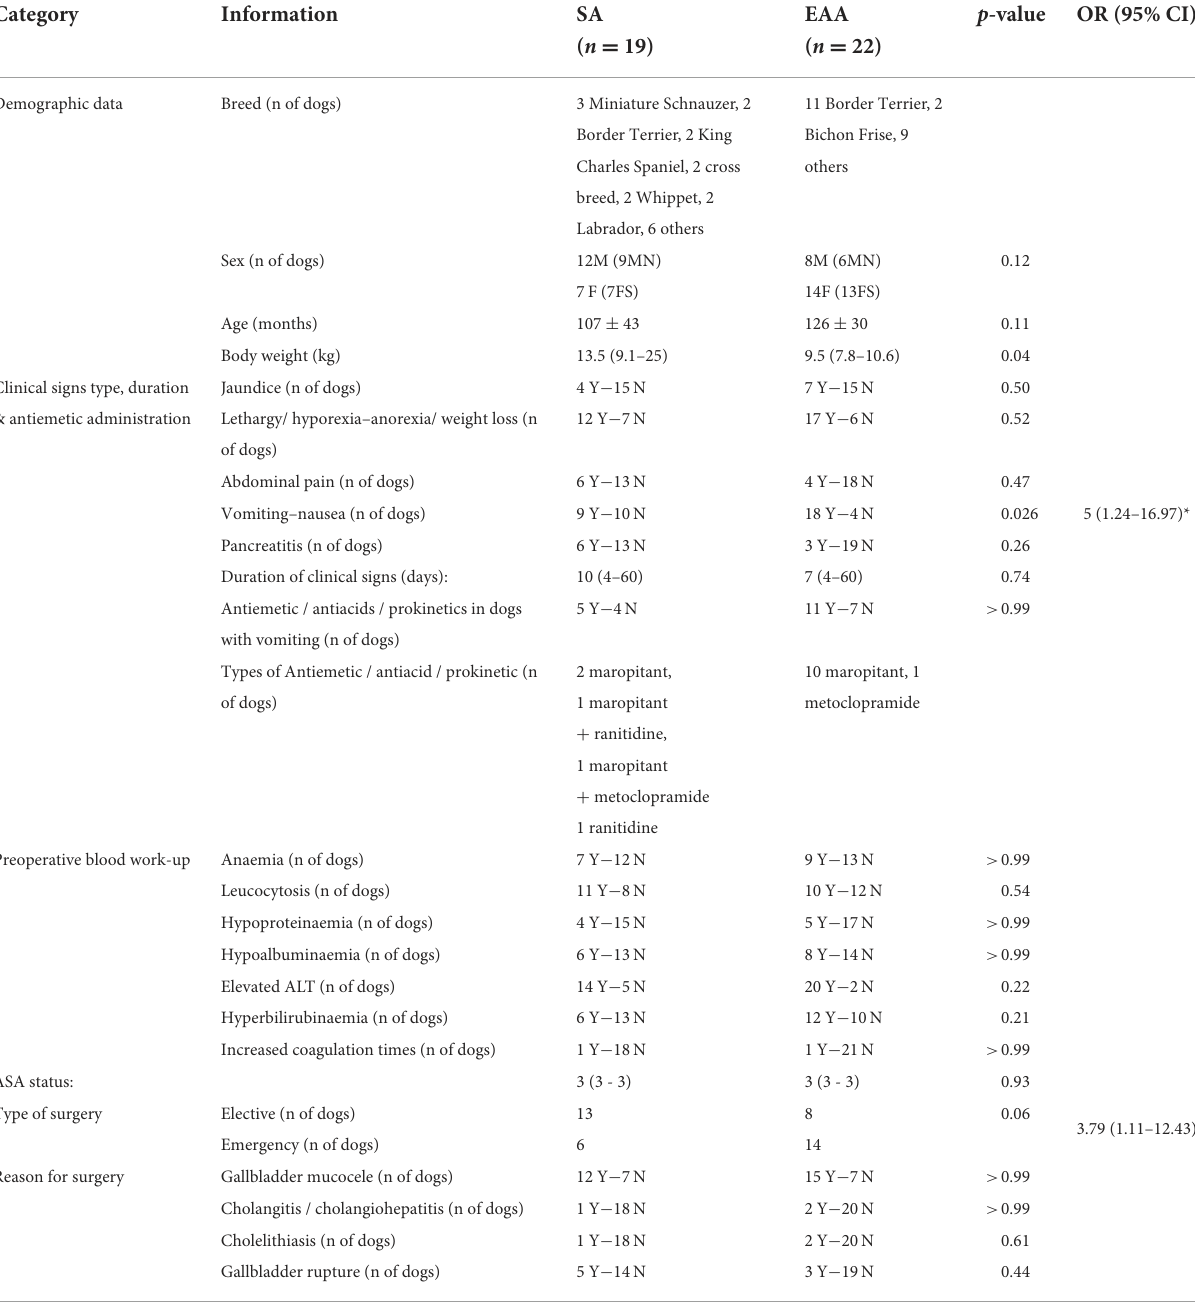
TABLE 1 Preoperative information recorded from a cohort of dogs undergoing cholecystectomy and in which systemic analgesia (SA) or extradural anaesthesia-analgesia (EAA) were